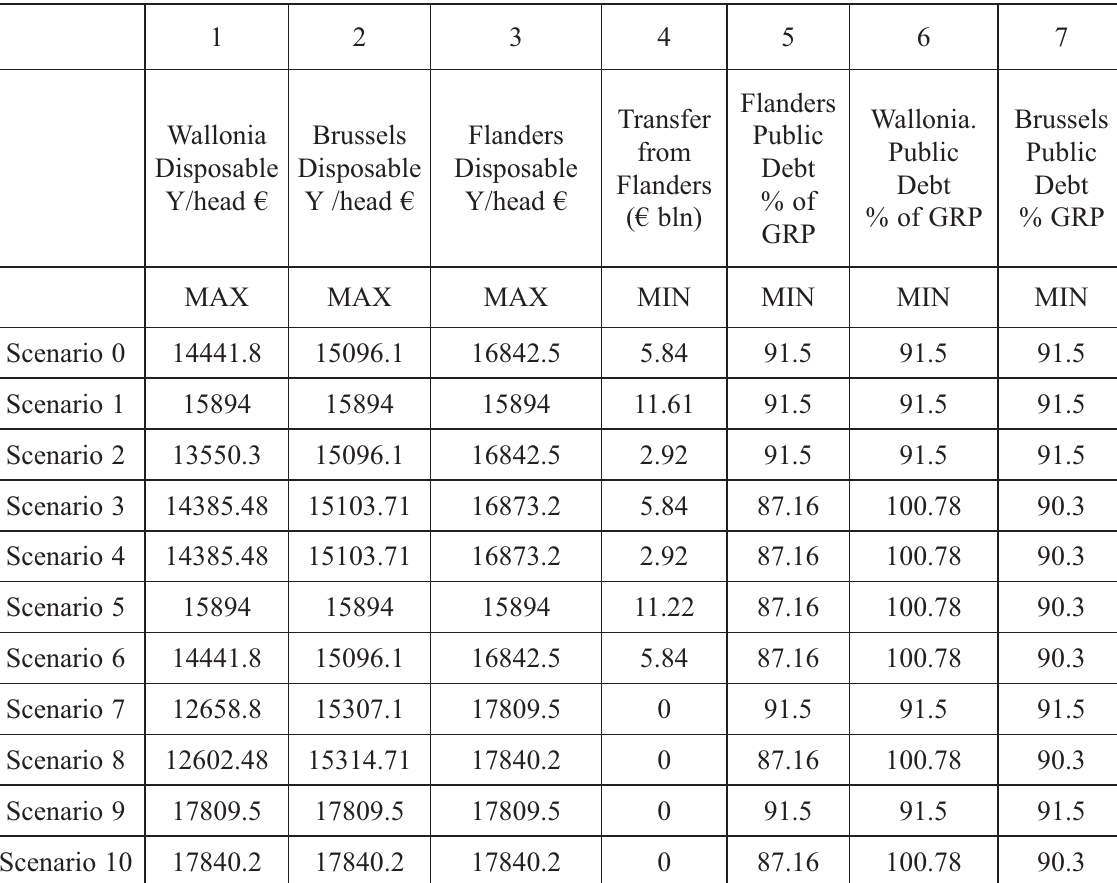
Table 5 . MOORA applied on 7 objectives for the Belgian regions (year 2005): Ratio System Part (5a until 5c) and Reference Point Approach